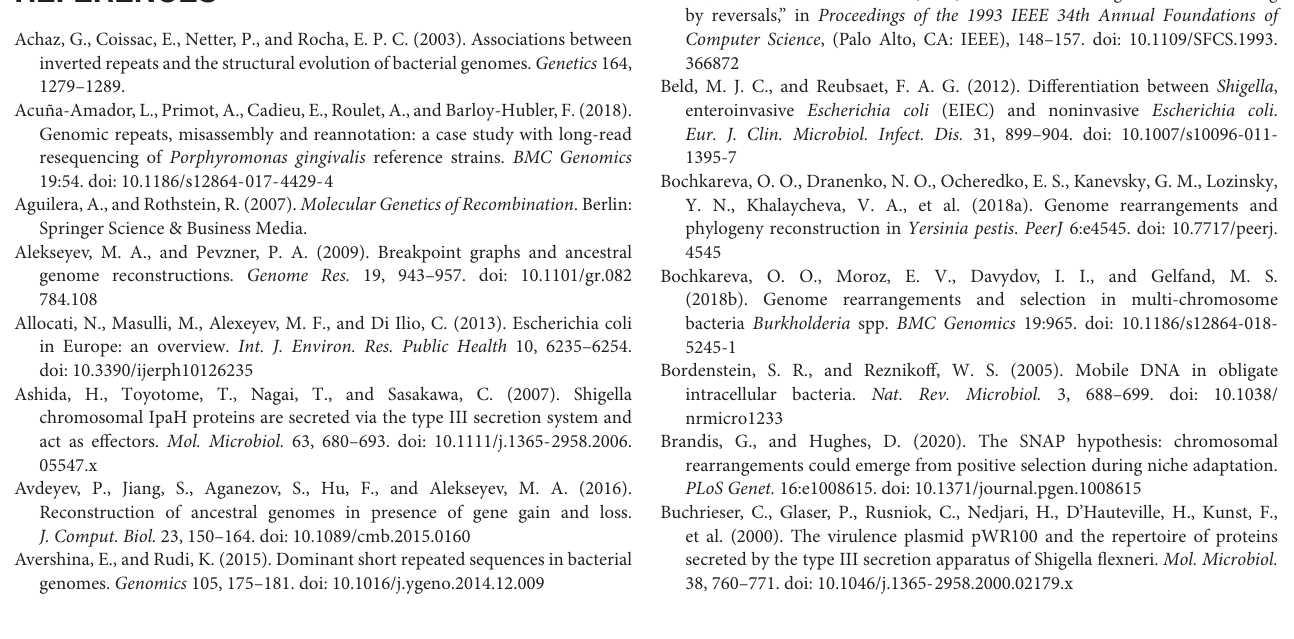
Supplementary Table 1 | The list of Escherichia coli and Shigella genomes included in the analyses. Supplementary Table 2 | Coordinates of synteny blocks. Supplementary Table 3 | Adjacencies of common synteny blocks. Supplementary Table 4 | Copy number of non-common synteny blocks. Supplementary Table 5 | Gene composition of synteny blocks surrounding Shigella -specific